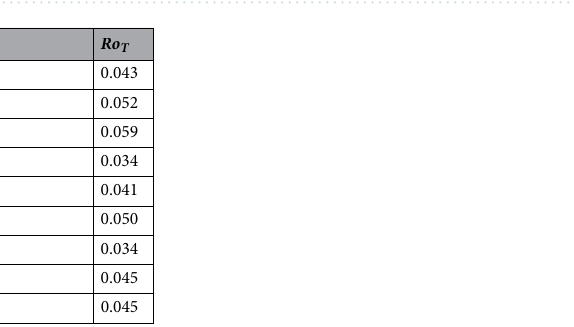
Figure 4. Temperature statistics before and after the opening. Zonal and temporal mean WST ( a ), and the standard deviation ( b ) and skewness ( c ) of the same signals after vs. before the opening. The data are acquired from 7 experiments, which are marked with different colors, and from 12 zonal contours (“latitudes”) shown by different symbols. In the legend, the distance of each “latitude” is given from the inner cylinder (of radius R 1 ) in the units of total gap width L = R 2 − R 1 (cf. Fig. 1). The figure was created using Gnuplot version 5.2, Release 5.2.8 (freely available and downloadable at http:// www. gnupl ot. info/).